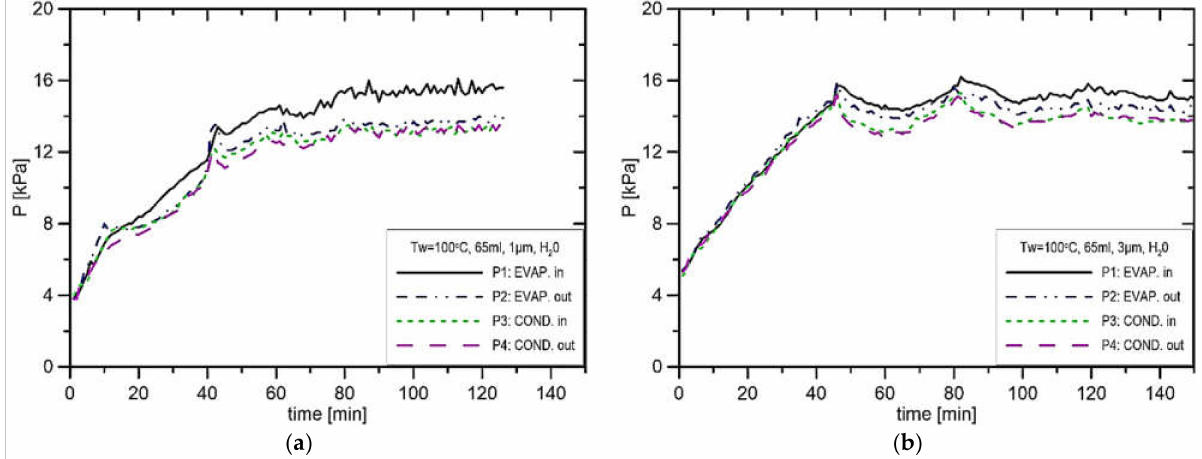
Figure 11. Distribution of pressure in function of time in case of water, charge volume 65 mL, T w = 100 ◦ C, ( a ) R p = 1 µ m, ( b ) R p = 3 µ m.